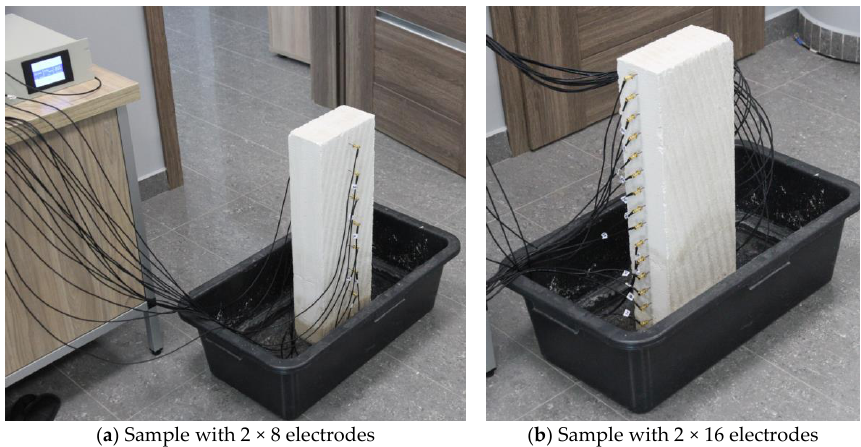
Figure 6. A tomographic laboratory to study the moisture inside the cellular lightweight concrete block.